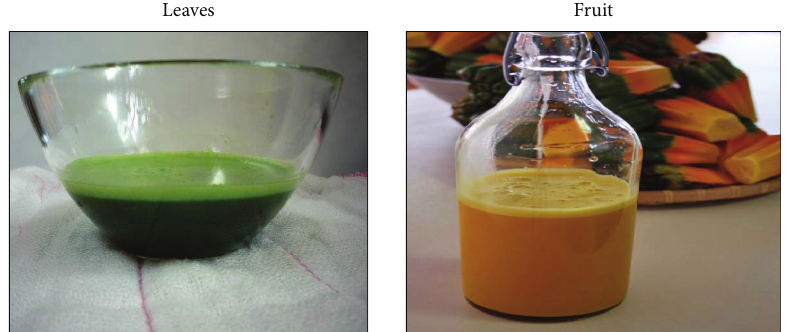
Figure 2: Nutritional aspects and staple food of Pandanus .